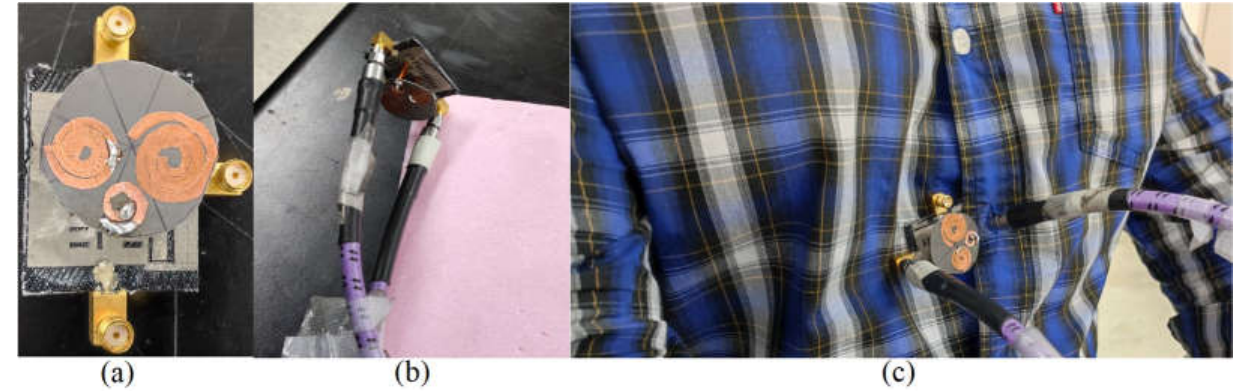
Figure 8. The measurement setup of the proposed antenna in both free space and on-body (( a ) fabricated antenna; ( b ) measurement in free space; ( c ) measurement on chest).